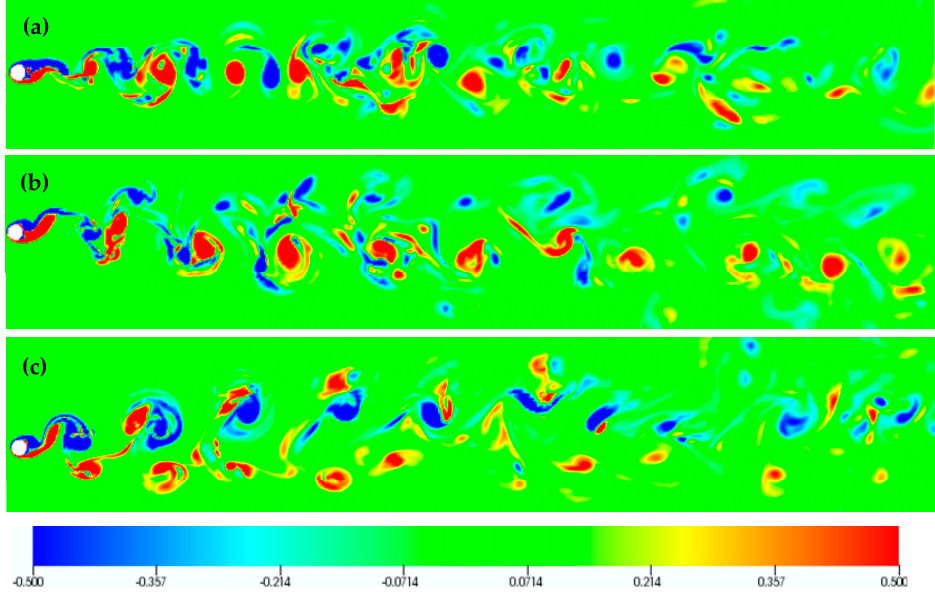
Figure 23. Clockwise cylinder oscillation: Instantaneous isocontours of spanwise vorticity for the plane z = 3 for F = 0.8 and ( a ) A y /D = 0.10, ( b ) A y /D = 0.30, ( c ) A y /D =